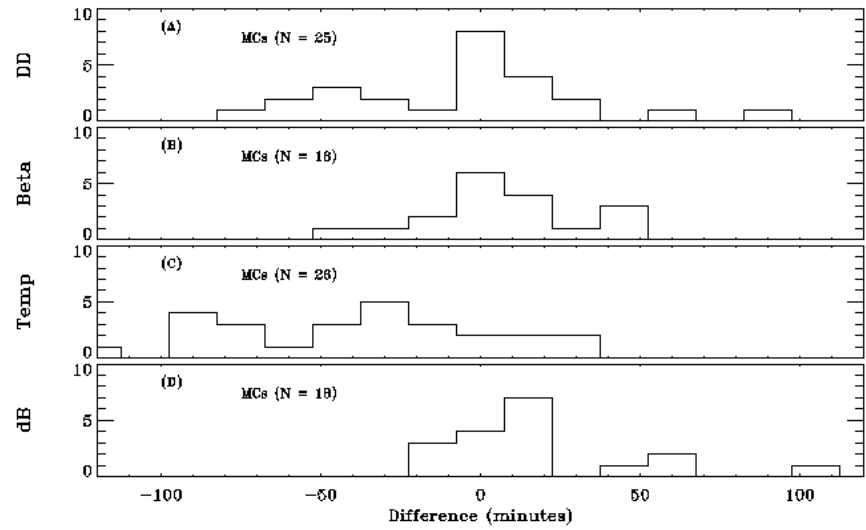
Fig. 6. Histograms giving the number of MCs that contributed to the estimate of a given 1t i =[ t B *(test) i –t B (VI)] ( i =1,.., 4), individually for the following: test #1 ( A , DD), test #2 ( B , 1β P ) , test #3 ( C , 1 Temp.), and test #4 (D, 1 | B | ) , for the N(total) = 26 MCs of Data Set #1, based on the 5min averages. The subscripts in the 1t i -equation here mean that the 1t ’s for every individual test’s estimate are being shown, not just the average 1t , so this differs from Eq. (1).